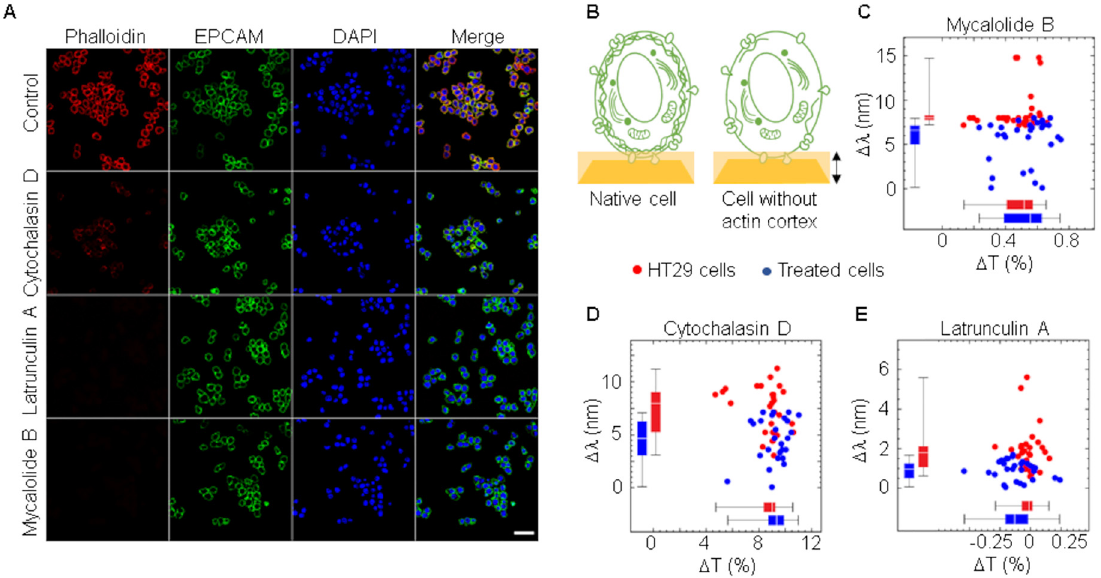
Figure 7: Spectral changes in cells without actin